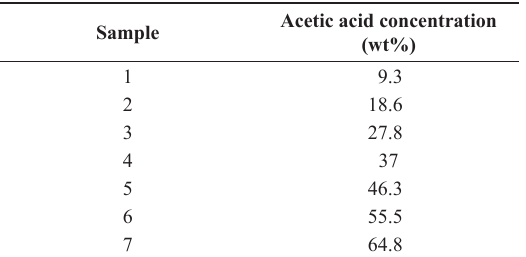
Table 1. Solution concentration of water/acetic acid (wt% ) Sample